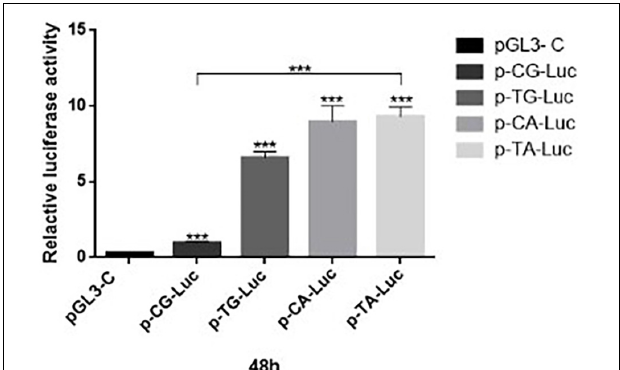
FIGURE 1 | Detection of dual-luciferase activity of 293T cells at 48 h after transfection. Promoter activities of recombinant plasmids p-CG-Luc ( p = 0.003, t = 4.88), p-TG-Luc ( p < 0.05, t = 16.38), p-CA-Luc ( p < 0.05, t = 8.19), and p-TA-Luc ( p < 0.05, t = 39.34), p-CG-Luc, p-TG-Luc, p-CA-Luc, and p-TA-Luc were much higher than that of the negative control plasmid PGL3-control with SV40 promoter. *** P < 0.001 three asterisks signify less than 0.001, indicating a significant difference, statistically